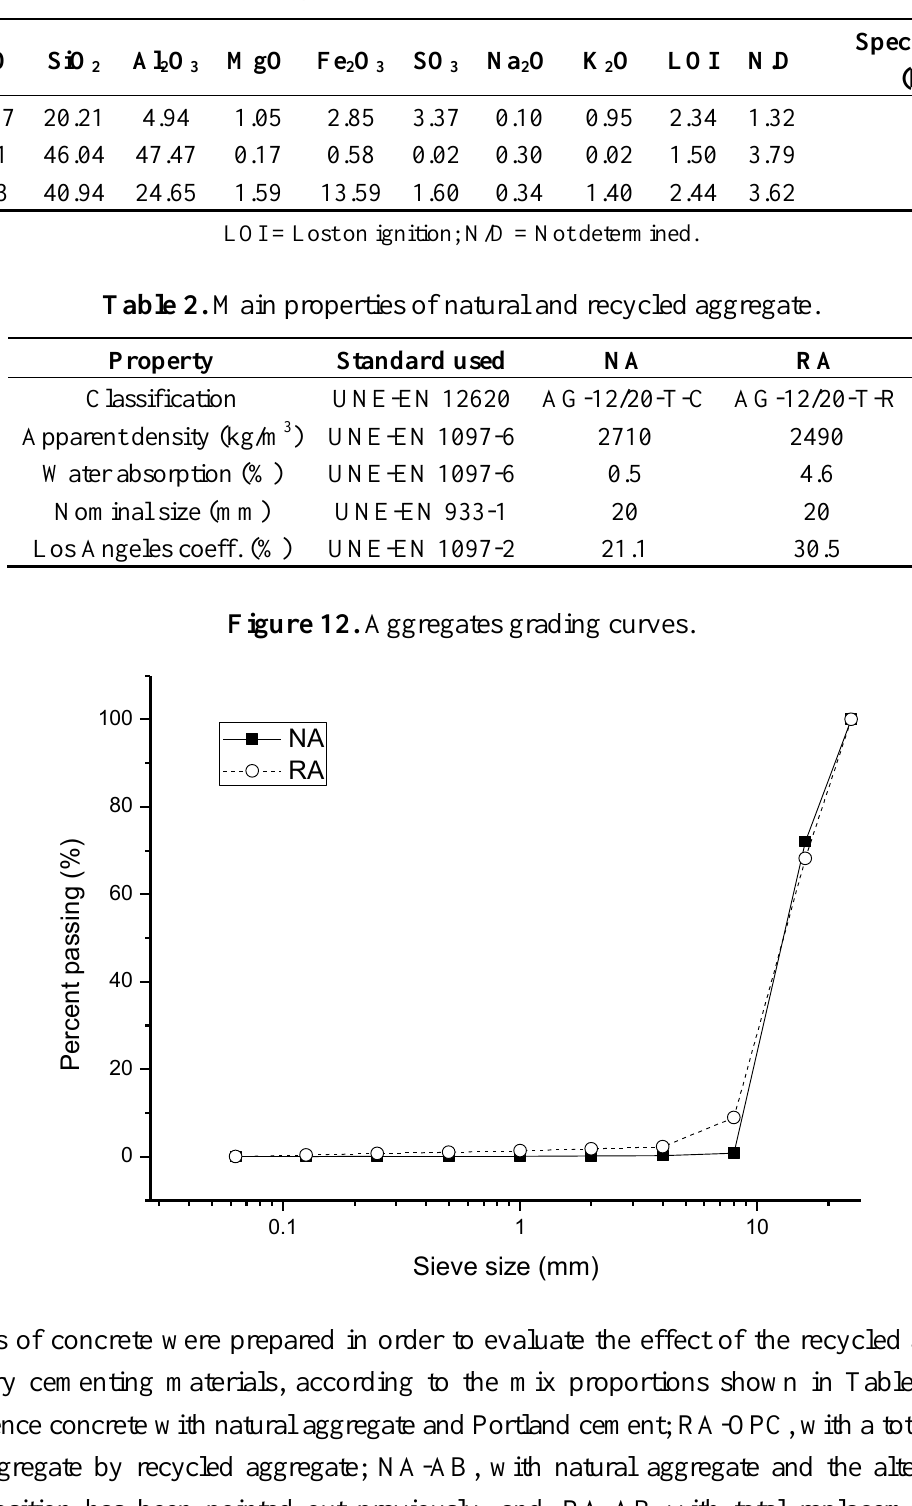
Table 1. Chemical composition of binders used in this research (% mass).